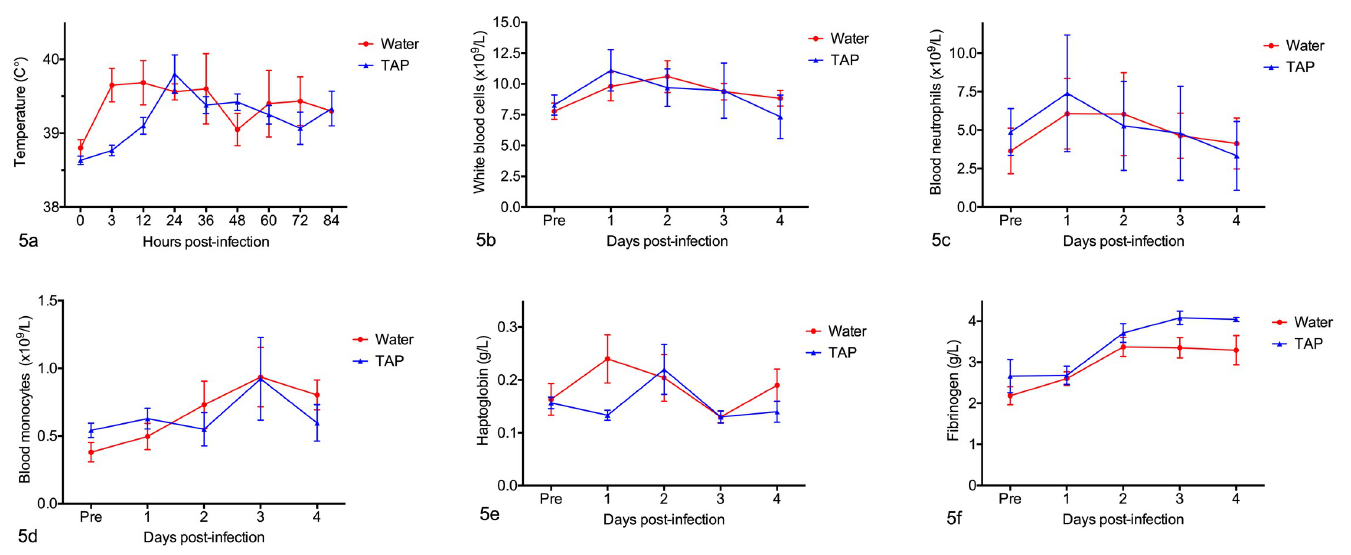
Fig 5. Rectal temperatures and clinical laboratory data at different times after infection with Mannheimia haemolytica . Six pairs of calves were challenged with M . haemolytica and treated with tracheal antimicrobial peptide (TAP) or water. Parameters were measured at the times shown before and after bacterial challenge. Mean ± standard error of the mean. (A) Rectal temperatures. (B) White blood cells. (C) Blood neutrophils. (D) Blood monocytes. (E) Serum haptoglobin. (F) Plasma fibrinogen. Since some pairs of calves were euthanized prior to the end point of 4 days post-infection, values may be compared between treatment groups but not among different time points.